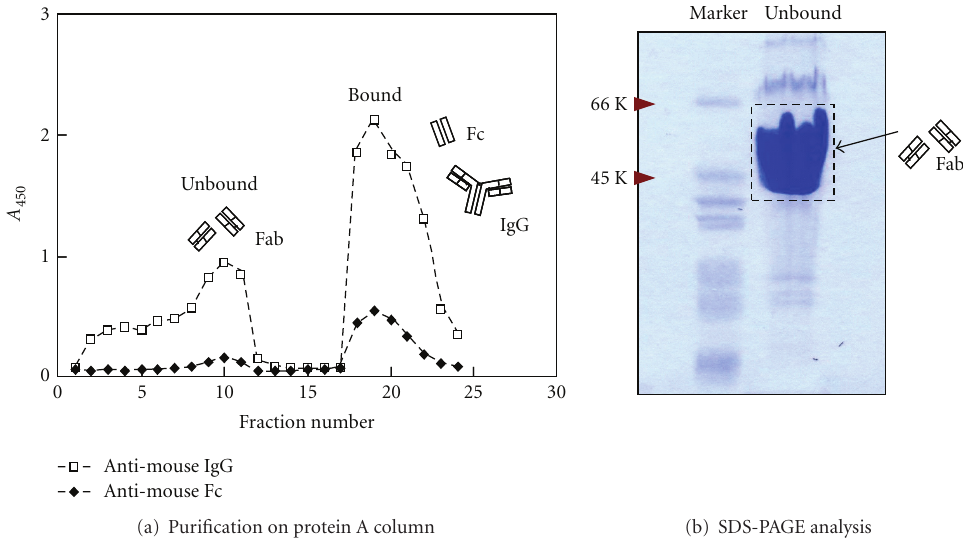
Figure 1: A ffi nity chromatography for the isolation of Fab from the antibody fragment mixture digested by Ficin protease and its identification. After loading the cleaved products on a protein A column, the unbound fractions were collected and the bound were eluted by shifting the medium pH. Each fraction was analyzed for total antibody and for that with Fc, which showed that the unbound included Fab and the bound consisted of fragments containing Fc (a). Furthermore, SDS-PAGE under non-reducing conditions confirmed that Fab was indeed the main component in the unbound portion. (b).